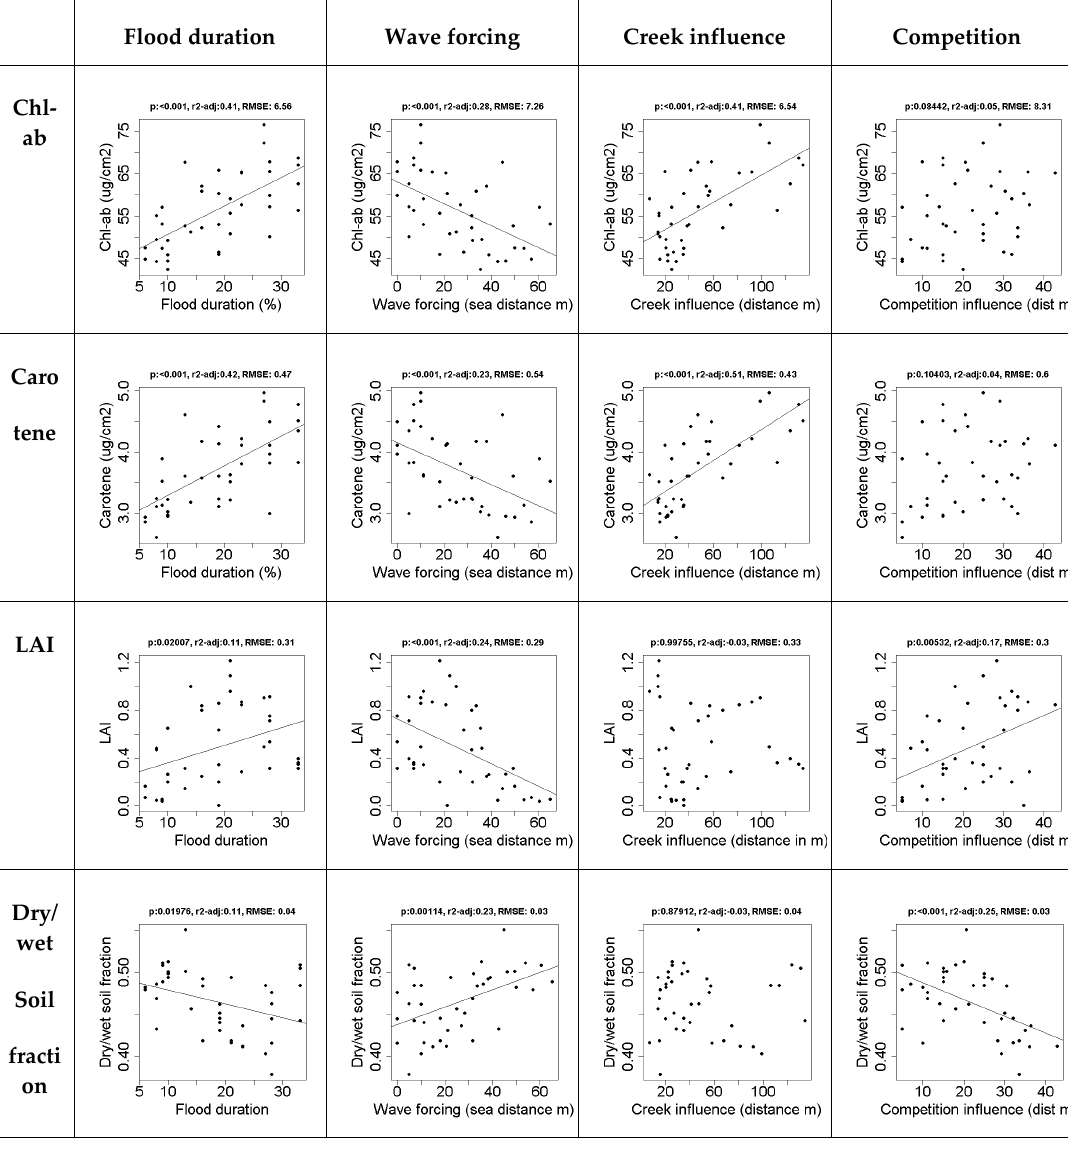
Figure 1. The effect of spatial drivers on in situ vegetation properties. The leaf properties (chl ‐ ab and carotene) are strongly affected by flood duration and creek formation. The canopy properties (LAI and the dry/wet soil fraction (1 ‐ soil moisture content)), are affected by flood duration, wave forcing and competition. Regression lines are shown for significant relationships: p < 0.05).